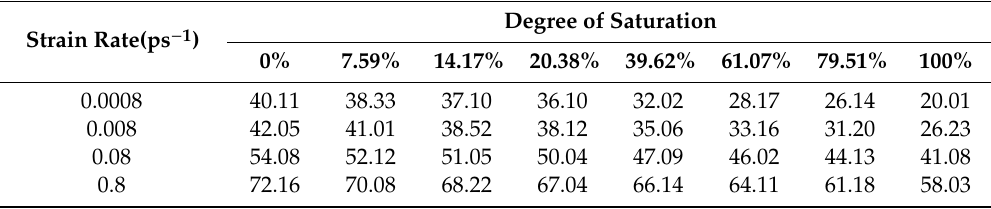
Table 2. Young’s modulus of C–S–H with di ff erent the degree of saturation under di ff erent strain rates Table 2. Young's modulus of C–S–H with different the degree of saturation under different strain rates (GPa) .